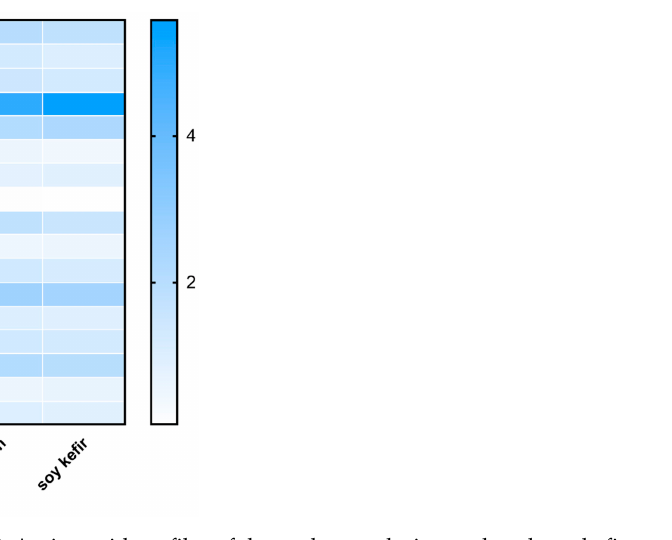
Figure 7. Amino acid profiles of the soybean solution and soybean kefir.